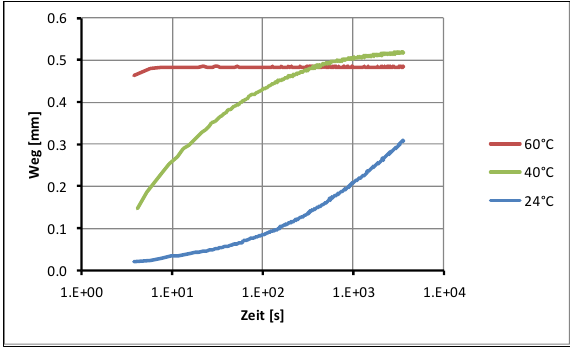
Fig. 14 Creep tests with Ködistruct LG specimen (30 mm x 10 mm x 2 mm) at 100 N.